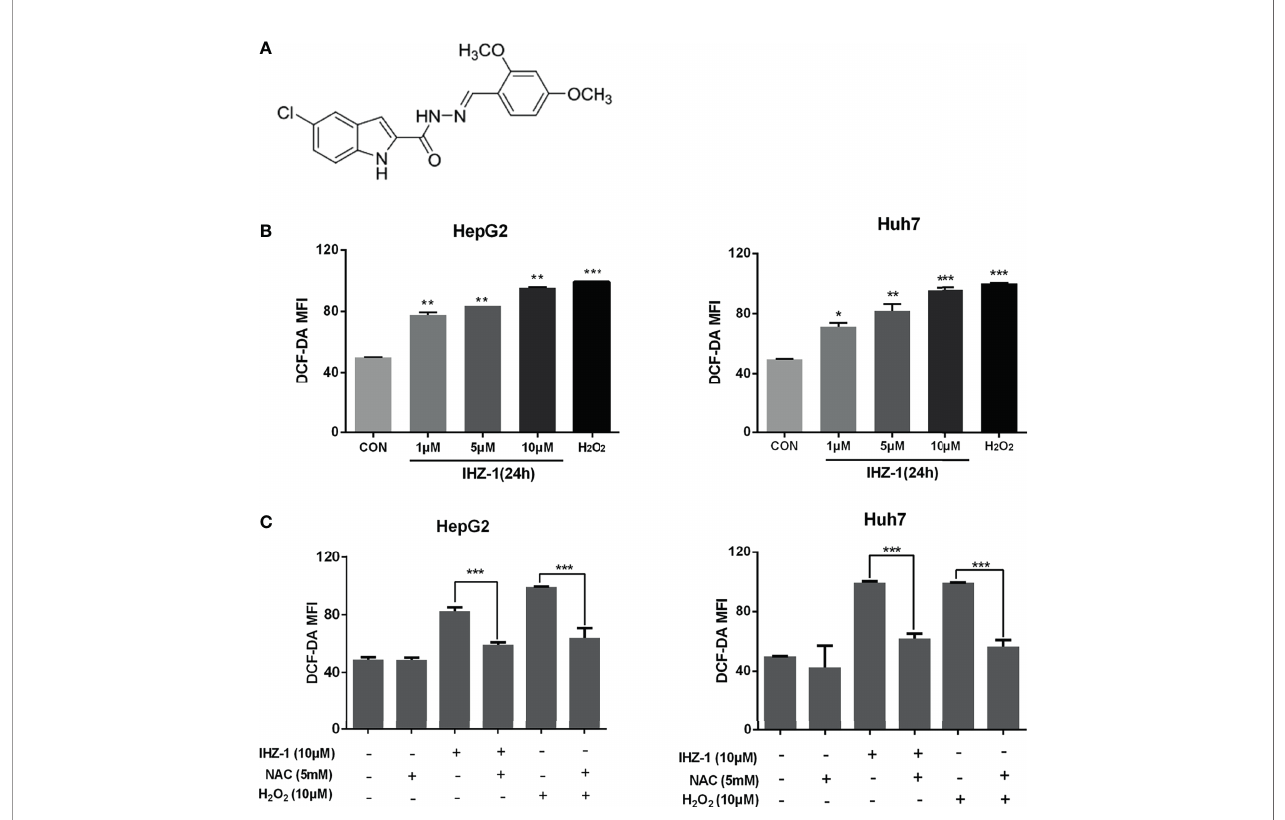
FIGURE 1 | IHZ-1 induced ROS generation in HCC cells. (A) Structural formula of compound IHZ-1. (B) Intracellular ROS level were measured by fl uorescence microscope with DCFH-DA staining after IHZ-1 treatment (C) or pretreated with NAC and analyzed by fl ow cytometer. *p < 0.05, **p < 0.01, and ***p <